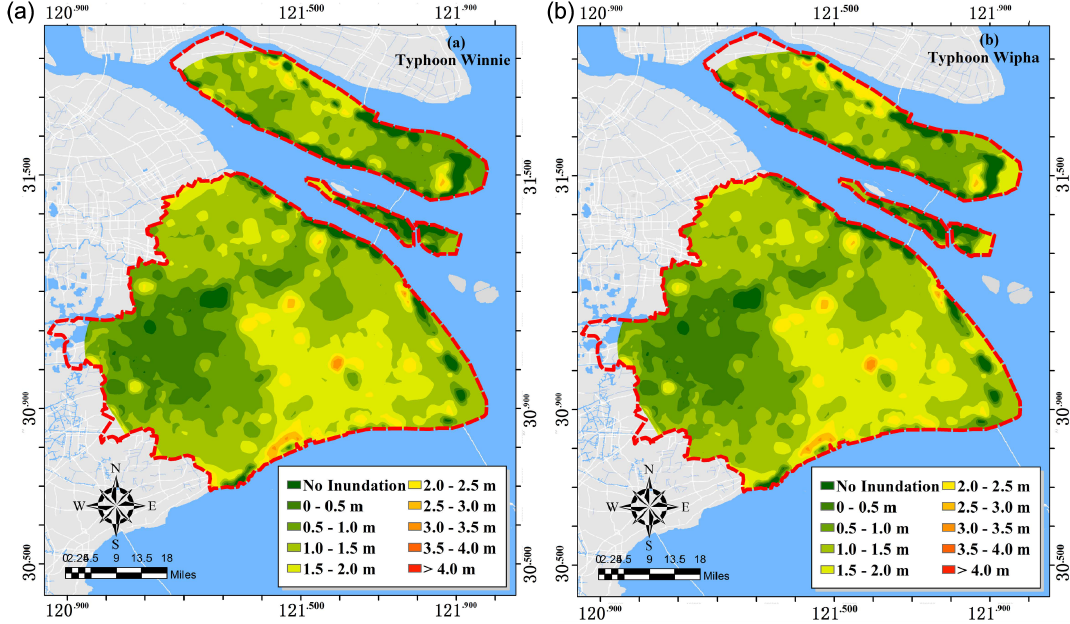
Figure 8. Distribution of the maximum inundation area and depth in Shanghai during typhoons (a) Winnie and (b) Wipha.